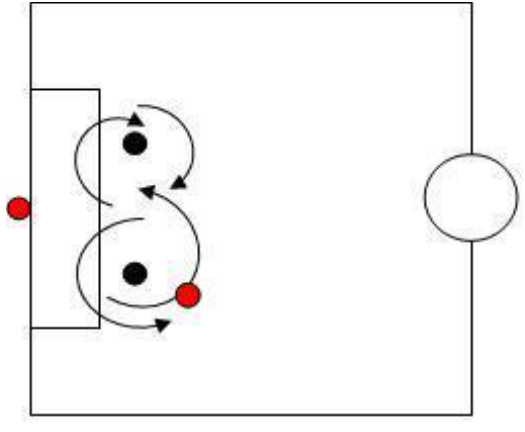
Figura 3. Exercício de reposição de bola Outra variação da reposição da bola após sofrer um gol acontece quando um jogador com uma pontuação alta repõem a bola para outro jogador também ponto alto e ao entrar em quadra, recebe a bola de volta através de um passe longo.